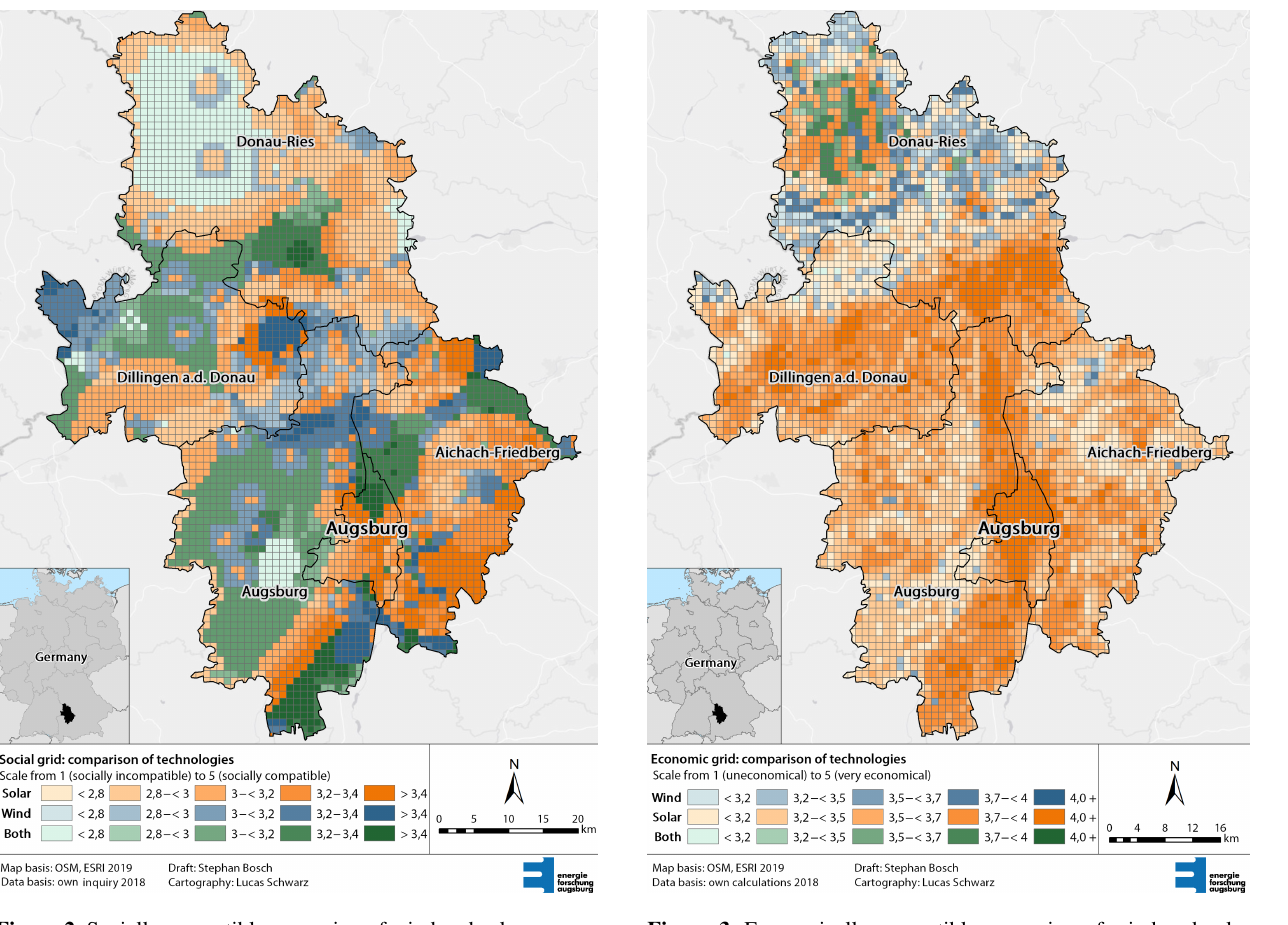
Figure 2. Socially compatible expansion of wind and solar energy. Figure 3. Economically compatible expansion of wind and solar